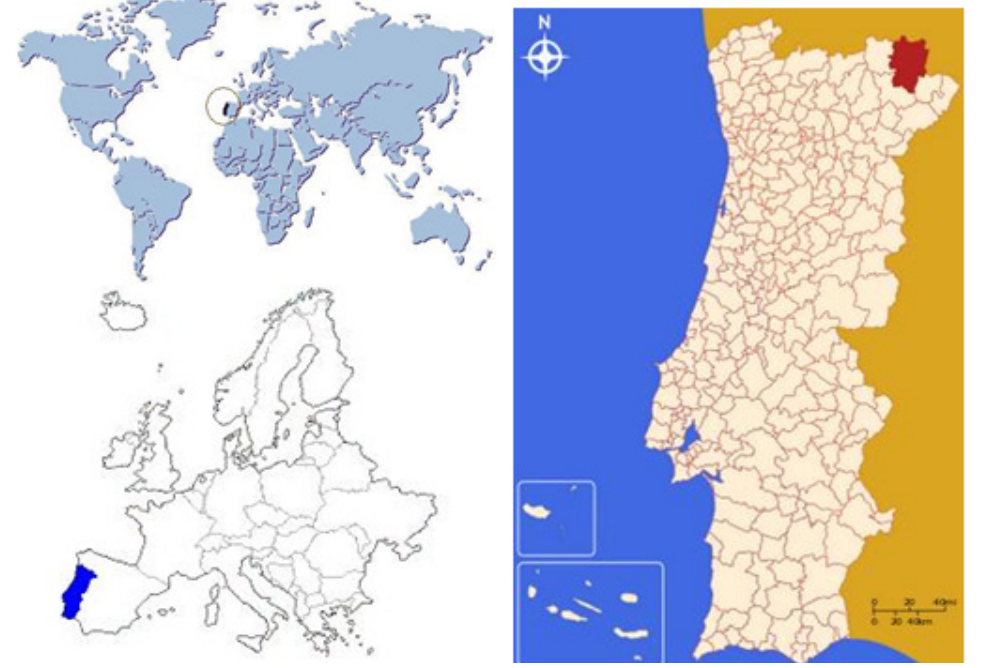
Figure 1: Location of the experimental